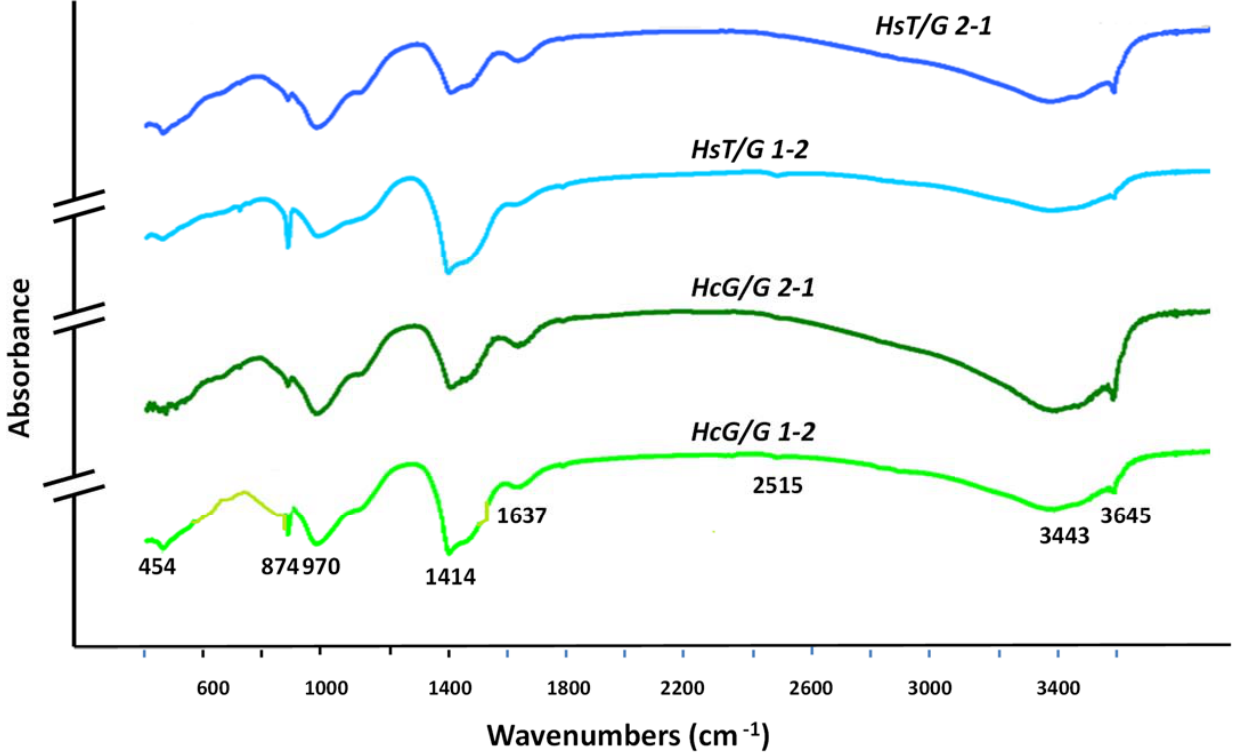
Figure 4. IR spectra for 90 days of blended cements.